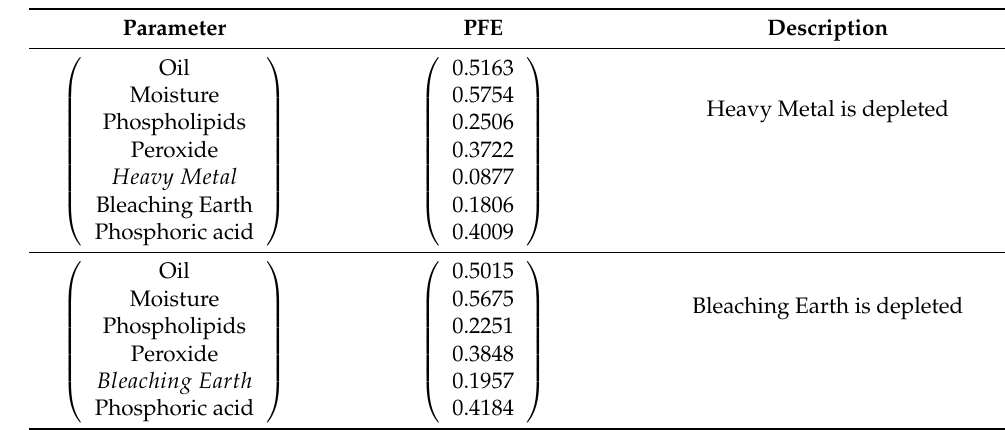
Table 6. The dynamic of graph G P